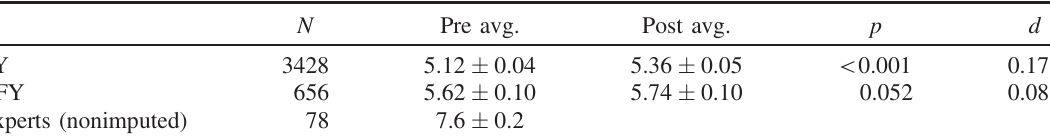
TABLE XIII. Scores across levels of physics maturity, where N is the number of responses in the imputed dataset (except for experts). Significance levels and effect sizes are reported for differences in pre- and post-test means. N